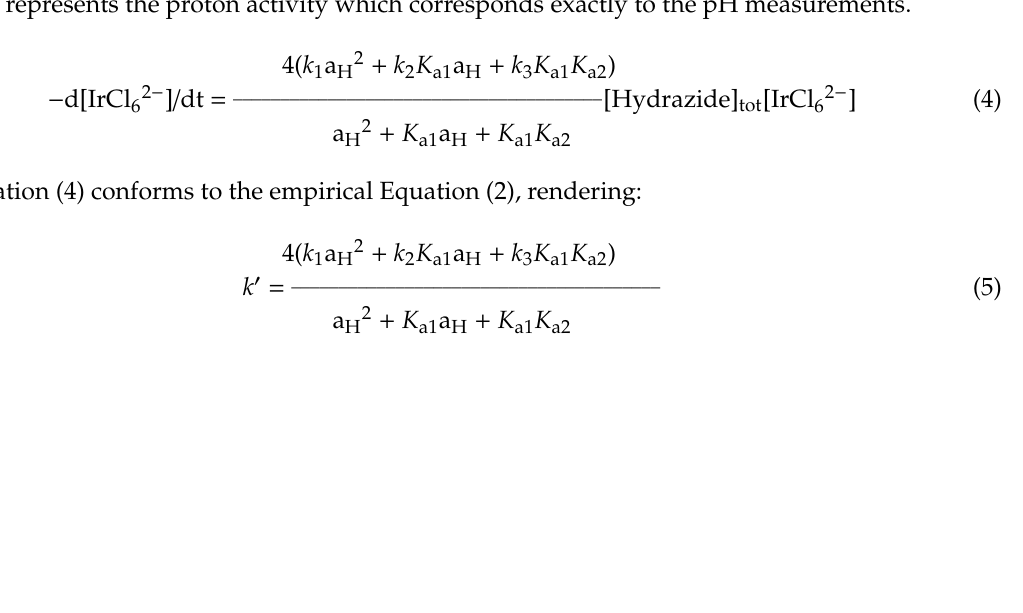
Figure 6. 1 H-NMR spectra recorded on a 400-MHz NMR spectrometer. ( Top ): 1 mM PAH in D 2 O. Assignments of chemical shift for C 6 H 5 -CH 2 -CONHNH 2 : -C H 2 -, δ 3.59 (s); C 6 H 5 -, δ 7.32–7.44 (m). ( Bottom ): A reaction mixture of 1 mM PAH and 5 mM [IrCl 6 ] 2 − in D 2 O after a reaction time of 5 h. Assignments of chemical shift for C 6 H 5 -CH 2 -COOH: -C H 2 -, δ 3.75 (s); C 6 H 5 -, δ 7.32–7.43 (m).